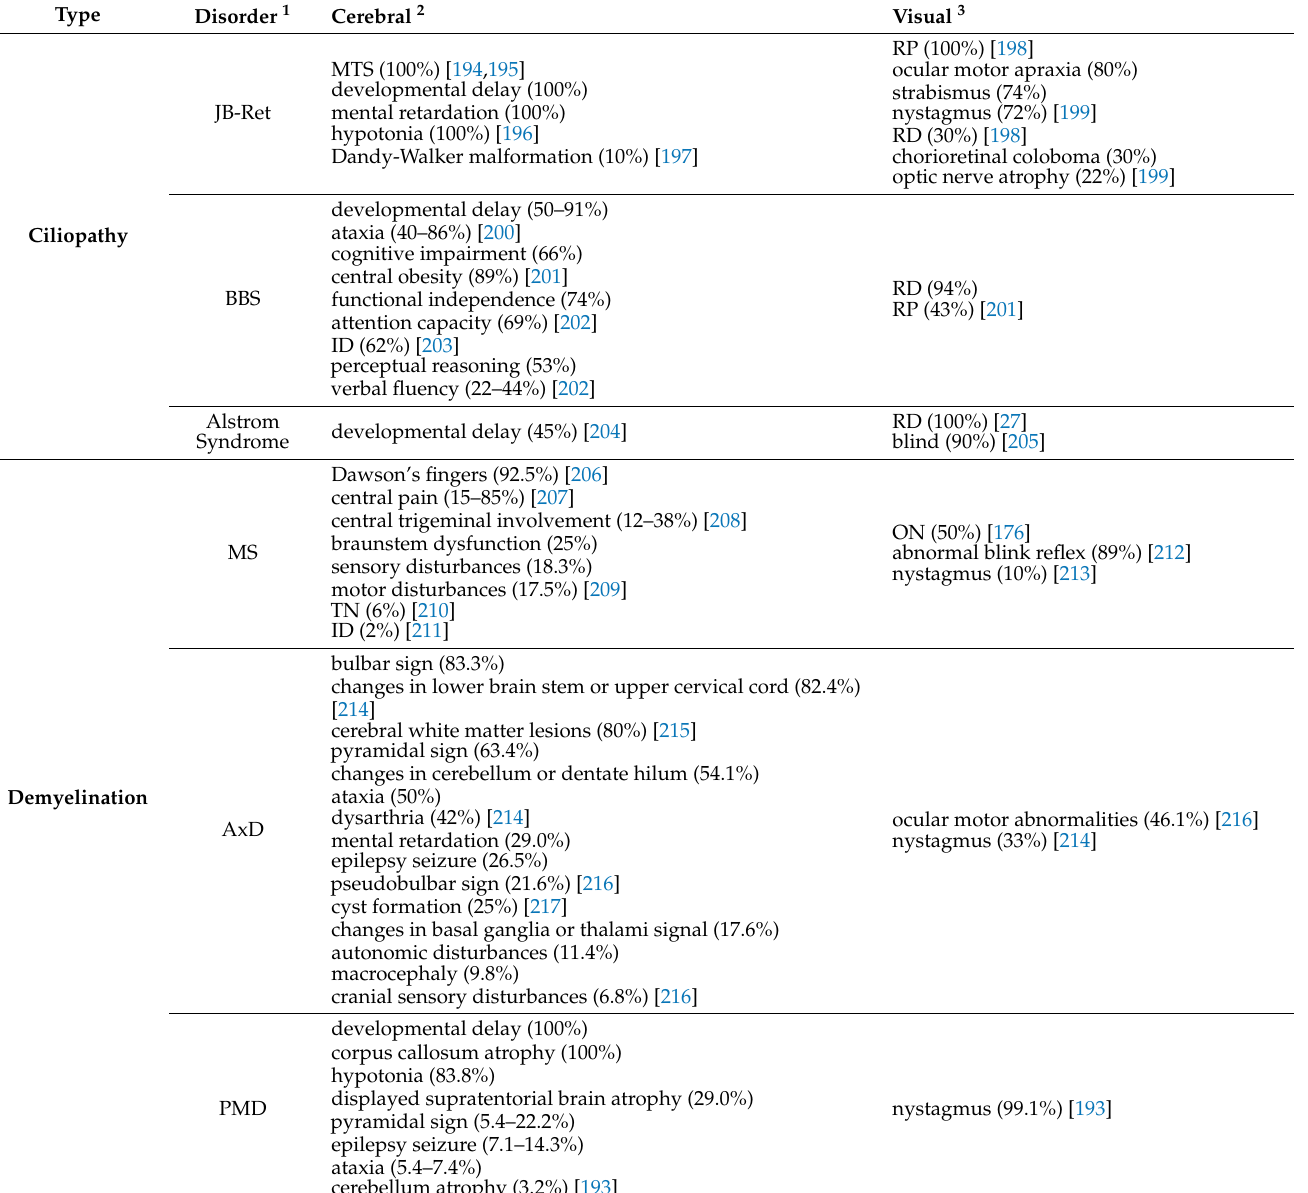
Table 3. Brain-Eye Correlations in Cerebral Visual